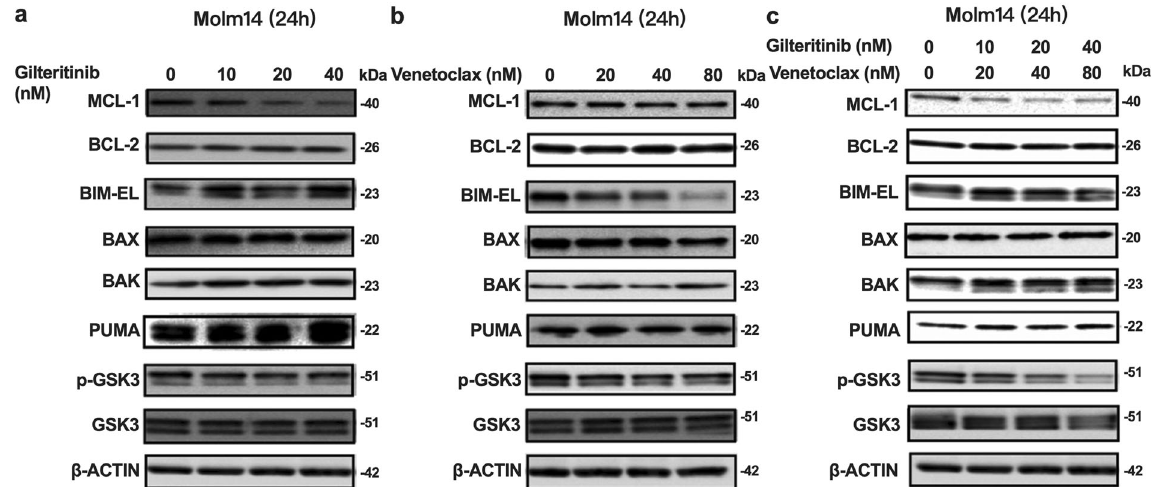
Fig. 4 Treatment with Gilteritinib and/or Venetoclax changes expression of some BCL-2 family members. Western blot for BCL-2 family members in Molm14 cells treated for 24 h with the indicated concentrations of a Gilteritinib, b Venetoclax, and c the